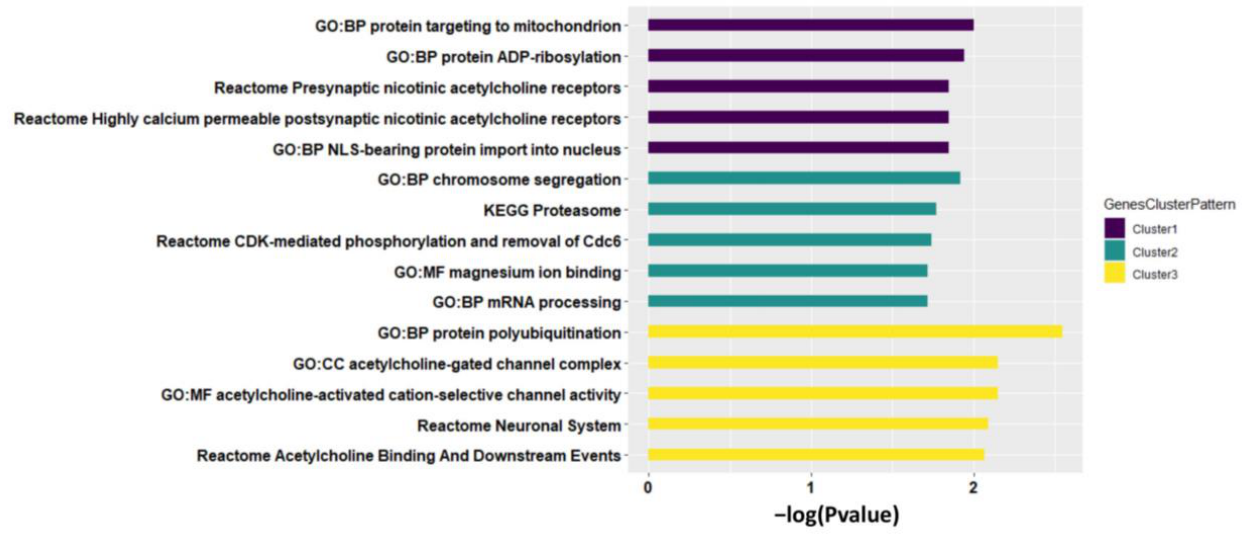
Figure 4. Top five pathways enriched by each cluster of genes identified, sorted by both p -value and pathway size. The p -value is from Fisher’s exact test.